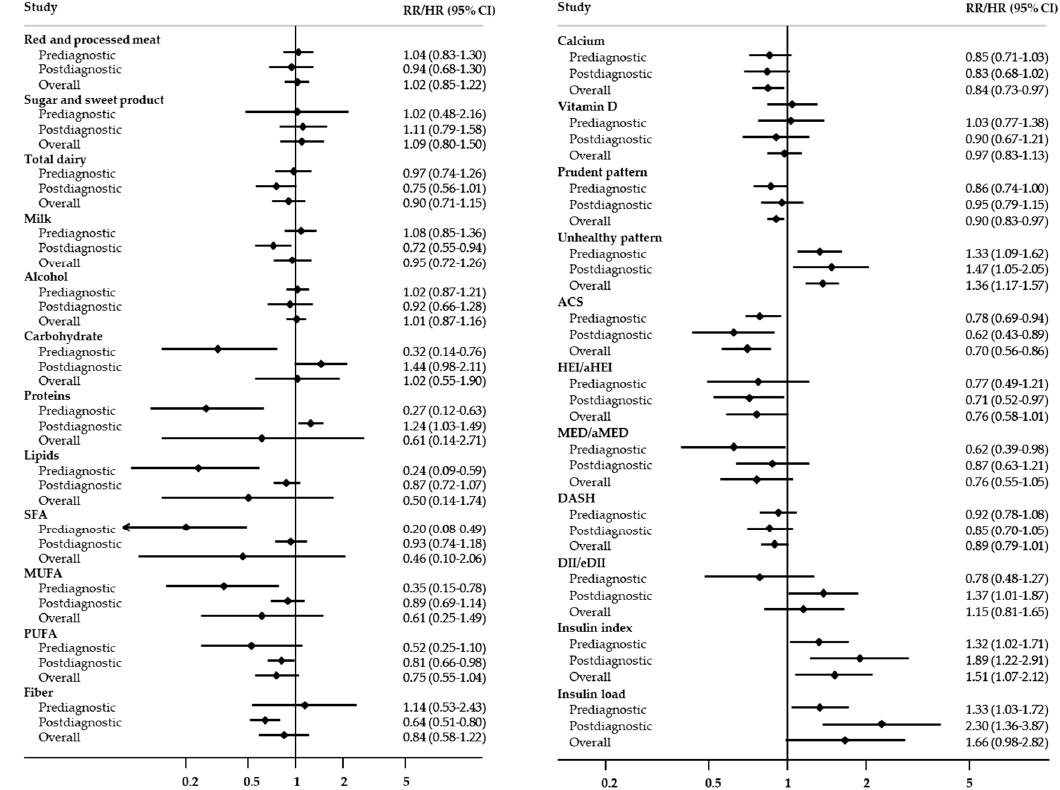
Figure 3. Comparison for the roles of prediagnostic and postdiagnostic intake in all-cause mortality. SFA, saturated fatty acids; MUFA, monounsaturated fatty acids; PUFA, polyunsaturated fatty acids; ACS, American Cancer Society recommendations score; HEI, Healthy Eating Index; aHEI, alternate Healthy Eating Index; DASH, Dietary Approaches to Stop Hypertension score; DII, Dietary Inflammatory Index; eDII, energy-adjusted Dietary Inflammatory Index; RR, relative risk; HR, hazard ratio; CI, confidence interval .